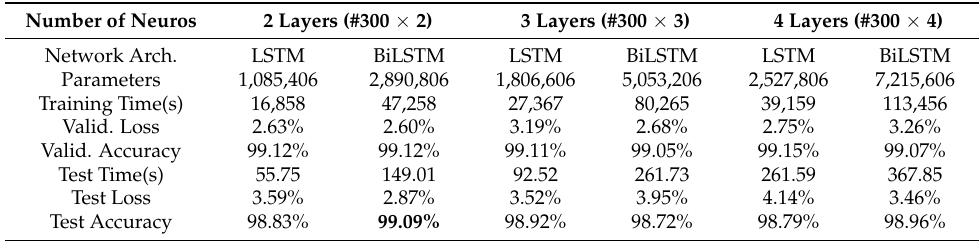
Table 4. Network performance of the multilayer LSTM and BiLSTM architecture with 300 neurons per